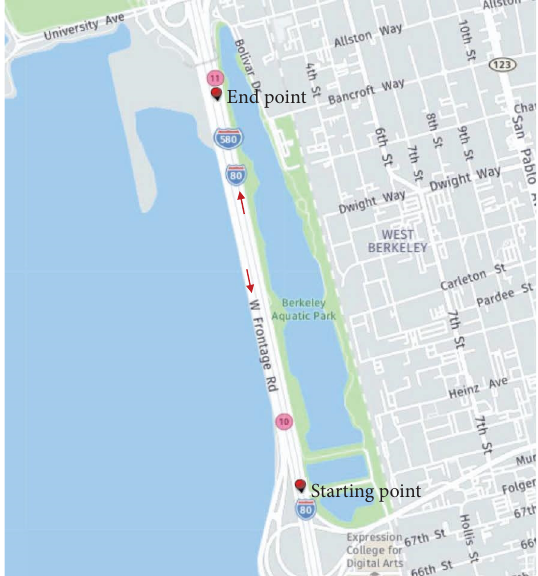
Figure 2: Te global view of the study area ( Source.